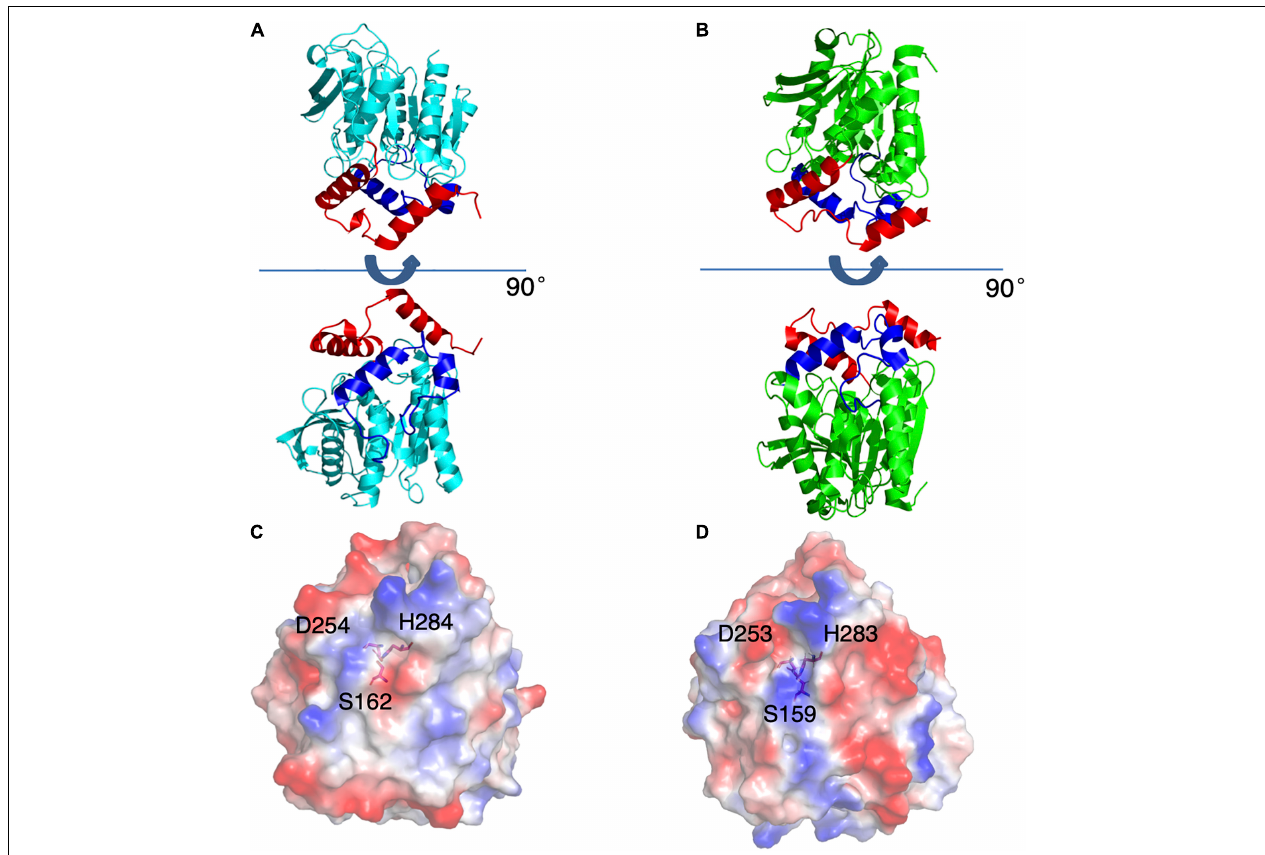
FIGURE 4 | Structures of E53 and Est8. (A) The 3D structure of E53, including the α / β -hydrolase fold (cyan), the carboxyl edge of the β -sheet (blue), and the cap subdomain (red) (B) The 3D structure of Est8 (PDB: 4YPV), including the α / β -hydrolase fold (green), the carboxyl edge of the β -sheet (blue), and the cap subdomain (red). (C,D) The surface contact potential of E53 and Est8, respectively. The catalytic triad was shown as stick models. Blue represents positive potential, and the red represents negative